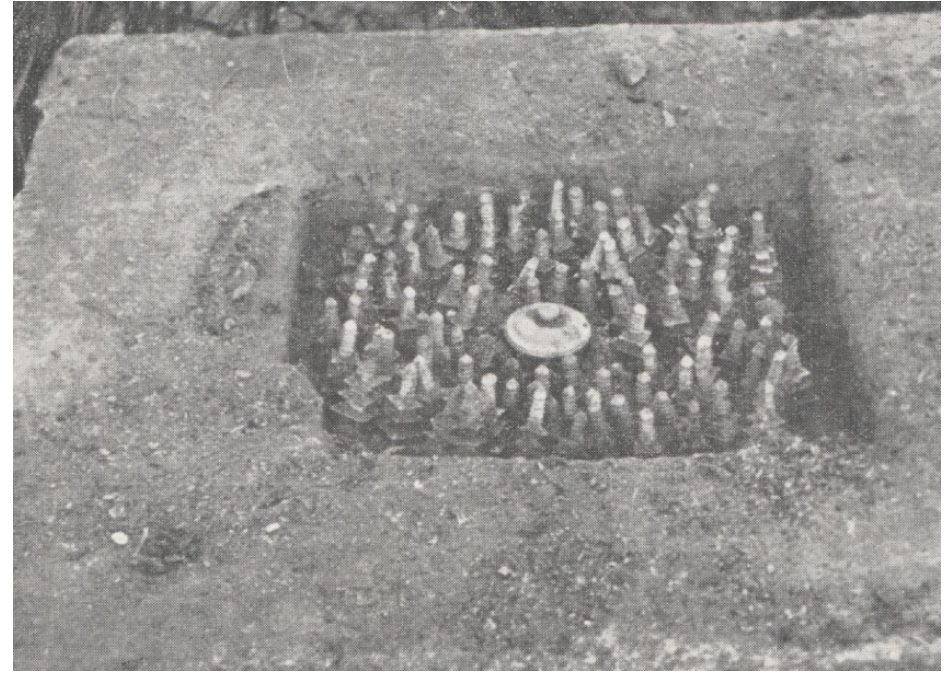
Figure 10. Miniature stupas in first story of three-story stone pagoda, S ŏ dong-ri, in Ponghwa, Gyeongsangbuk-do, Korea (photograph 1962, at the time of excavation). [Source: (Hwang 1980, p. 6)], Unified Silla; miniature stupas are owned by Ky ŏ ngju National Museum.